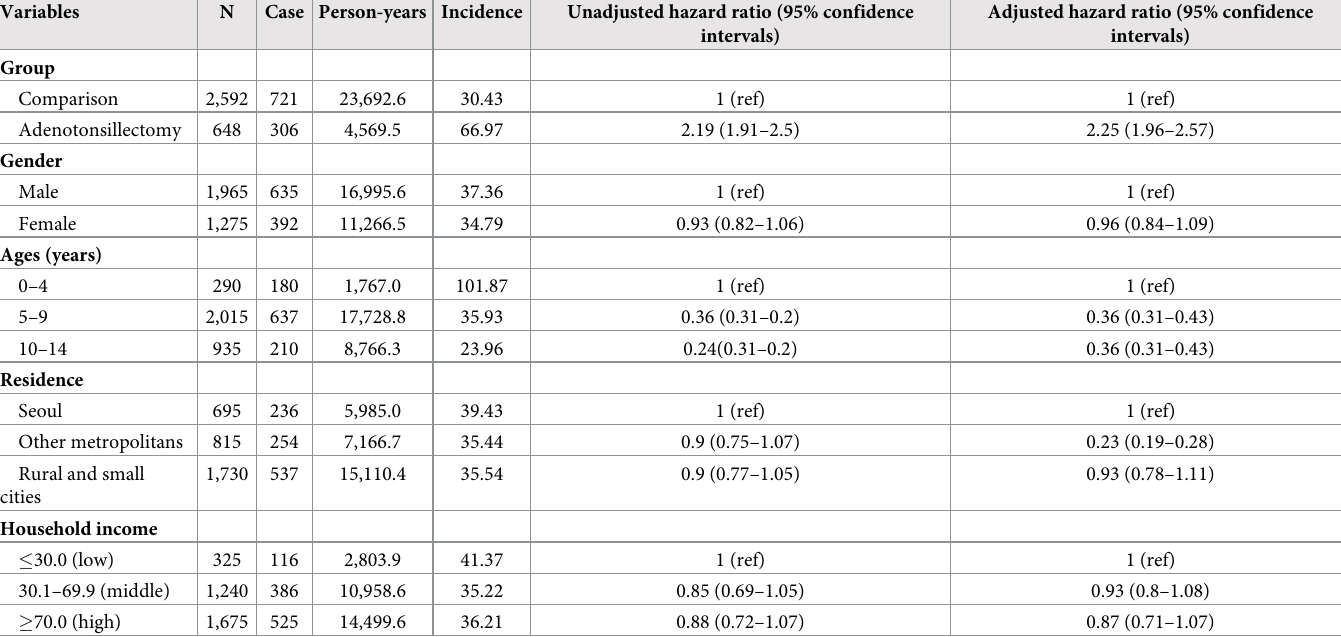
Table 2. Incidence per 1,000 person-years and HR (95% CIs) of asthma during the 11-year follow-up period. Variables N Case Person-years Incidence Unadjusted hazard ratio (95% confidence